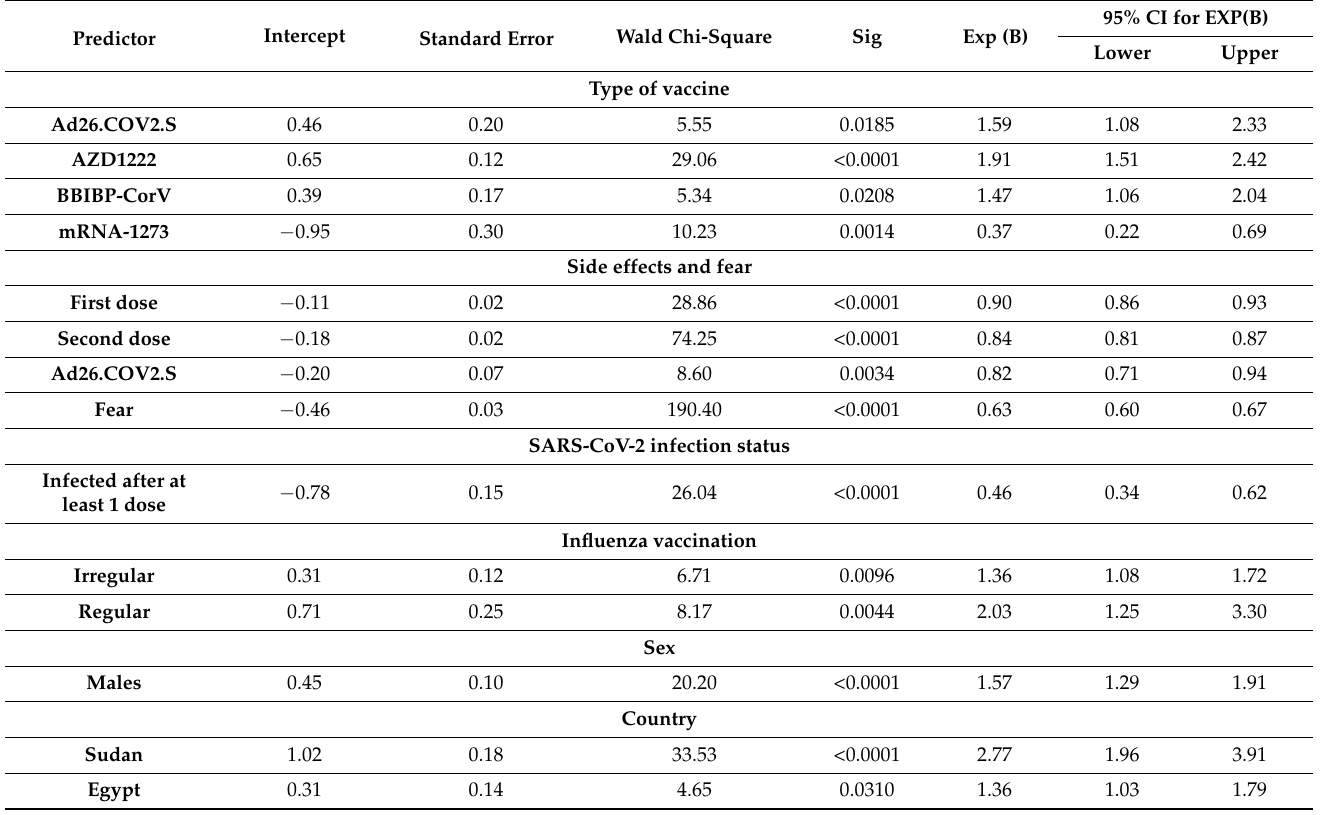
Table 4. The univariate logistic of the significant predictors of accepting COVID-19 vaccine booster dose.